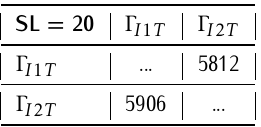
Figure 16. Virtual probable light signatures for trajectory segment Deva to Pites ti (via Sibiu) with SL=20 and ρ ,